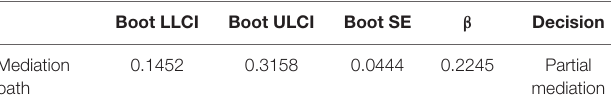
TABLE 3 | Mediation effect.